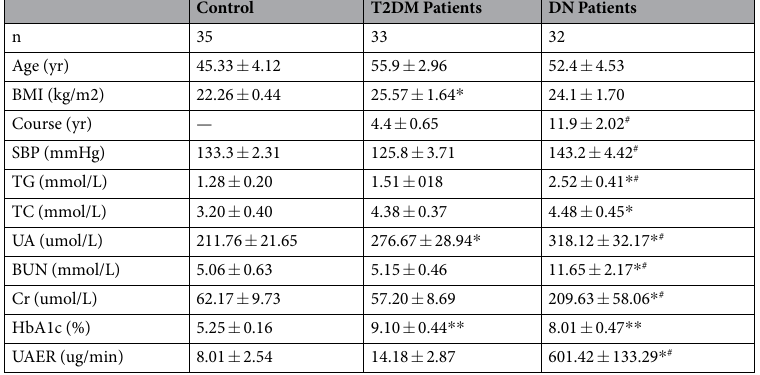
Table 1. Characteristics of Patients and Controls and Laboratory Test Results. T2DM: type 2 diabetes mellitus, DN: diabetic nephropathy, BMI: body mass index, SBP: systolic blood pressure, TG, triglyceride, TC: serum total cholesterol, UA: uric acid, BUN: blood urea nitrogen, Cr: serum creatinine, HbA1c: glycated hemoglobin, UAER: urinary albumin excretion rates. * Compared to the control group: P < 0.05. ** Compared to the control group: P < 0.01. # Compared to the T2DM group: P <